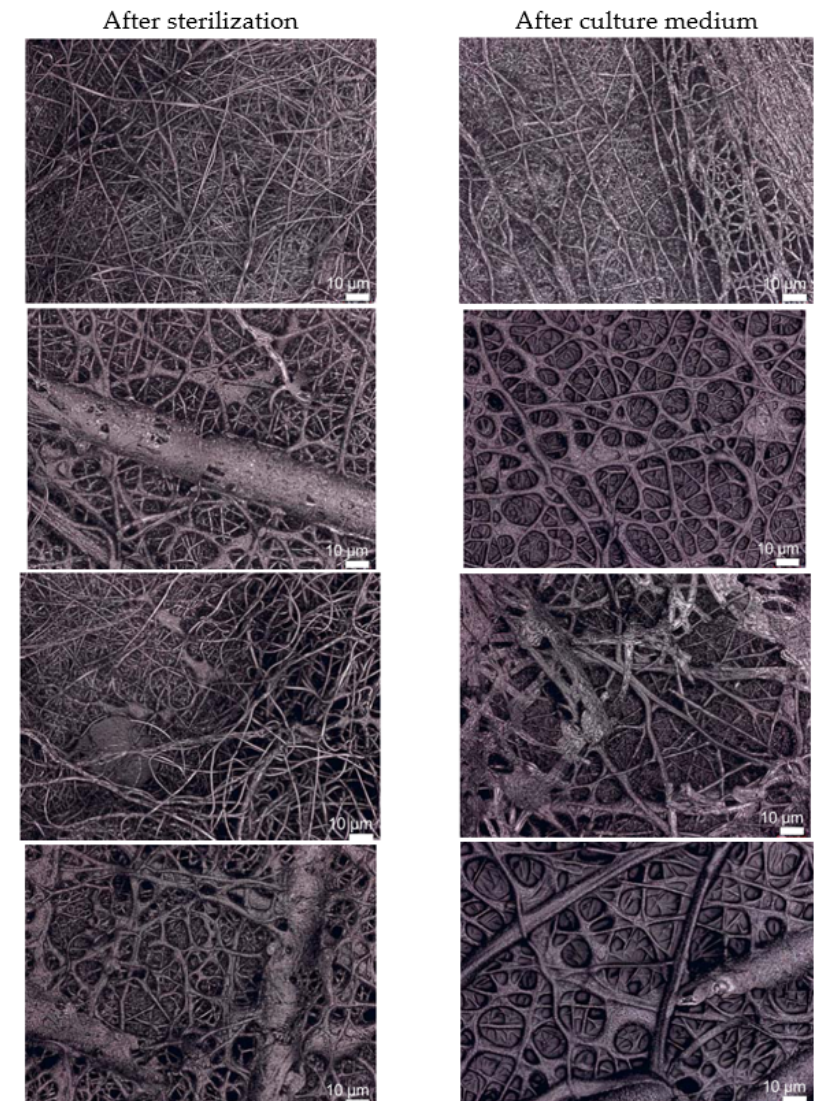
Figure 8. ( a ) UV radiation to N95 mask at University of Nebraska and ( b ) Hydrogen peroxide vapor generator at Duke University Hospital [120], and ( c ) Sterilization conditions [119].